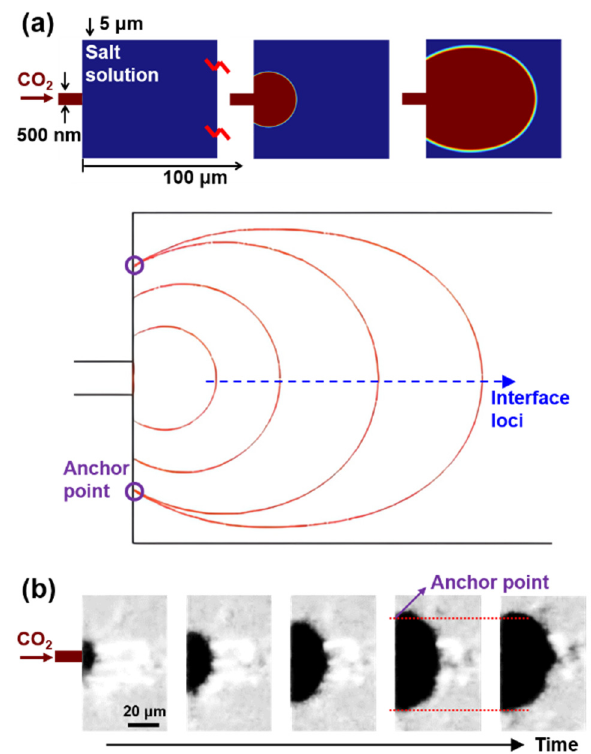
Figure 6. ( a ) Simulation of CO 2 displacing salt solution at the connection between a 500-nm channel and a 5- µ m pore. The loci of the CO 2 -water interface are plotted by combing multiple frames of simulation results. ( b ) Experimental results of precipitated salt accumulating at a pore inlet. The precipitated salt is colored black for clarity.